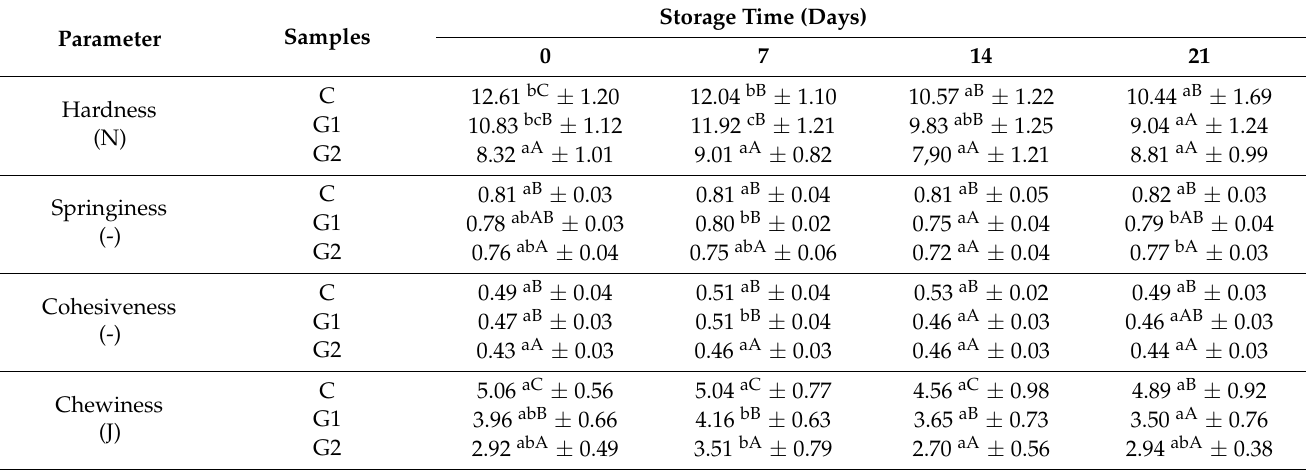
Table 4. The effect of ginger rhizome and storage time on the texture parameters of pork